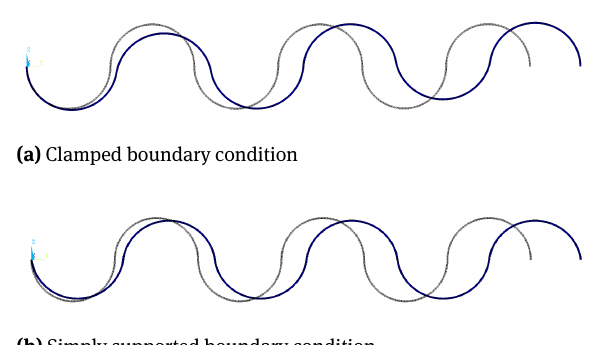
Figure 23: Scaled displacement of a corrugated panel subjected to loading in the direction of corrugation (LC 2). The plots highlight the influence of support conditions on the resulting